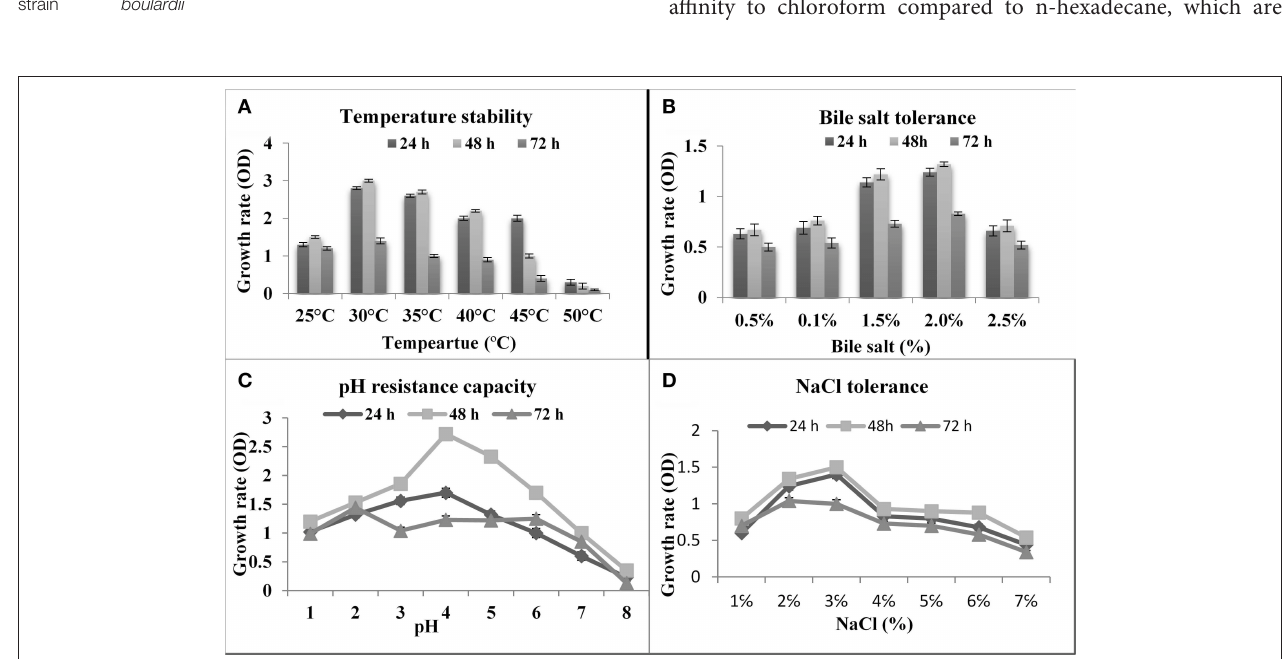
FIGURE 2 | Effect of temperature, bile, pH and NaCl on the growth of S. boulardii. (A) Temperature stability. (B) Bile salt tolerance. (C) pH resistance capacity. (D) NaCl Tolerance.